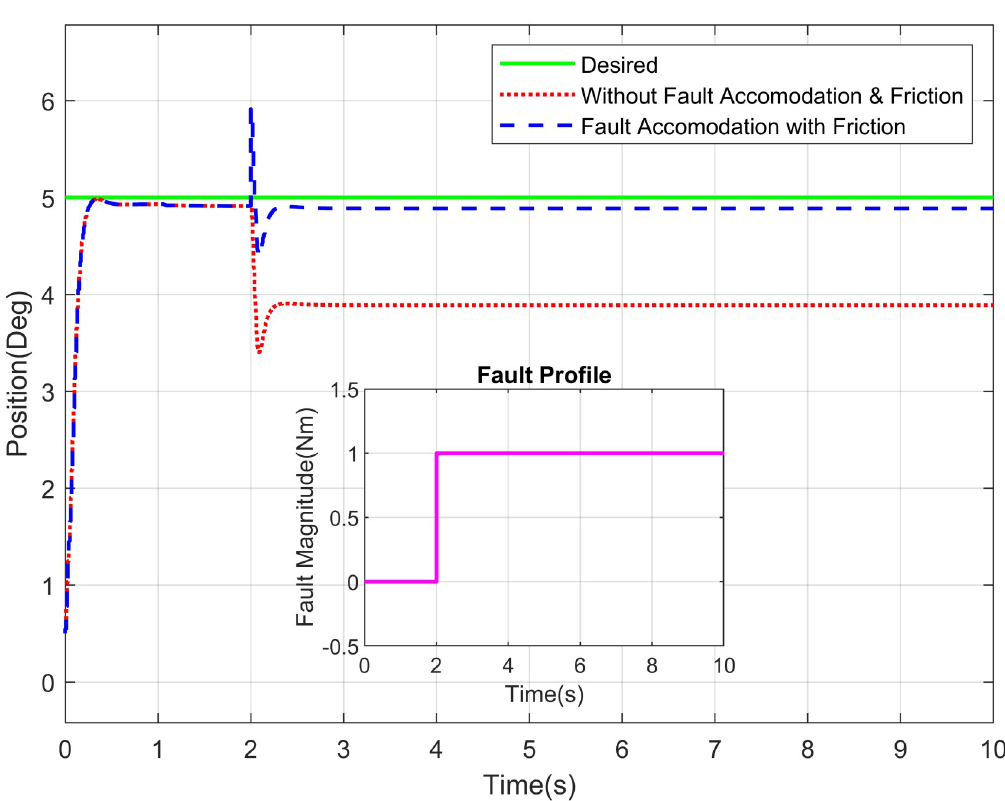
Fig 16. Position tracking of waist joint of a robot manipulator with abrupt fault profile.